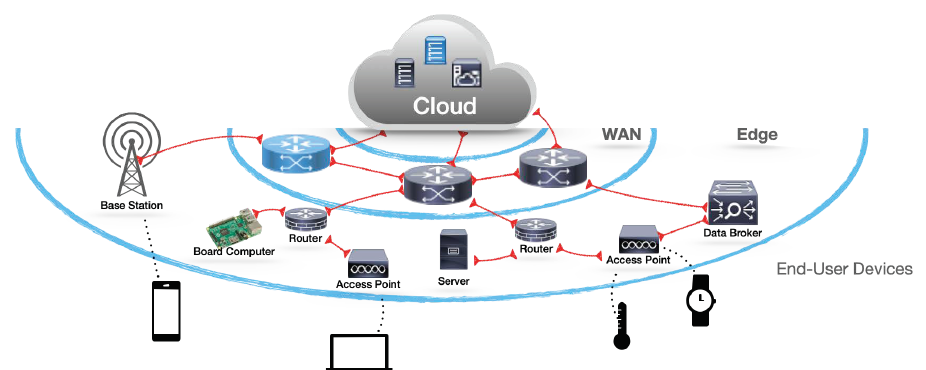
Figure 2. An Edge-Computing